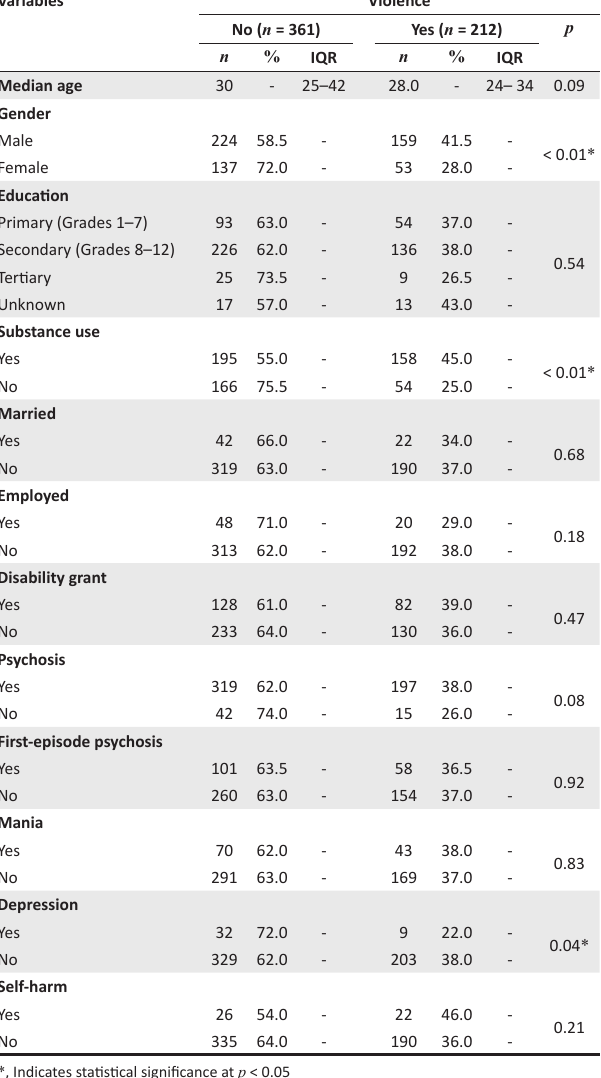
TABLE 3: Demographic and clinical characteristics of patients where violence was reported.